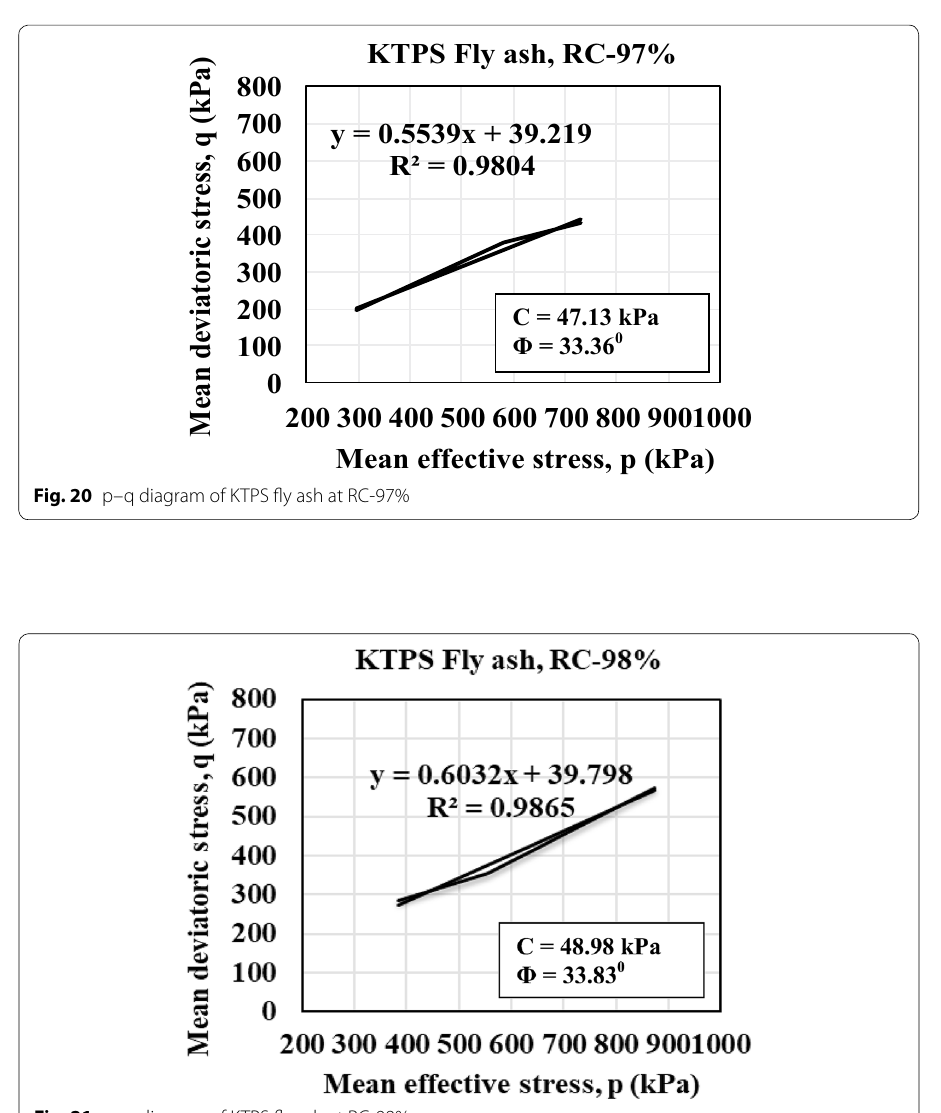
was found to be 464.14 kPa, 724.95 kPa and 879.03 kPa respectively. In the case of 98% relative compaction under the same confining pressure deviatoric stress was observed to be 350.31 kPa, 630.82 kPa and 740.22 kPa while for 99% relative compaction, the val- ues are found to be 448.05 kPa, 648.415 kPa and 981.84 kPa respectively. Figures 26, 27 and 28 represent modified envelope failure (p–q diagram) for KTPS bottom ash at RC-97%, RC-98% and RC-99%. From the results, it is observed that the shear strength properties like friction angle and cohesion value for bottom ash at RC-97%, RC-98% and RC-99% are 30.62°, 30.07° and 33.77°; and 77.73 kPa, 48.17 kPa and 46.07 kPa respec- tively (Table 3). The friction angle of each sample was in the range of 30°–40°, and it can be used as a light weight embankment material.